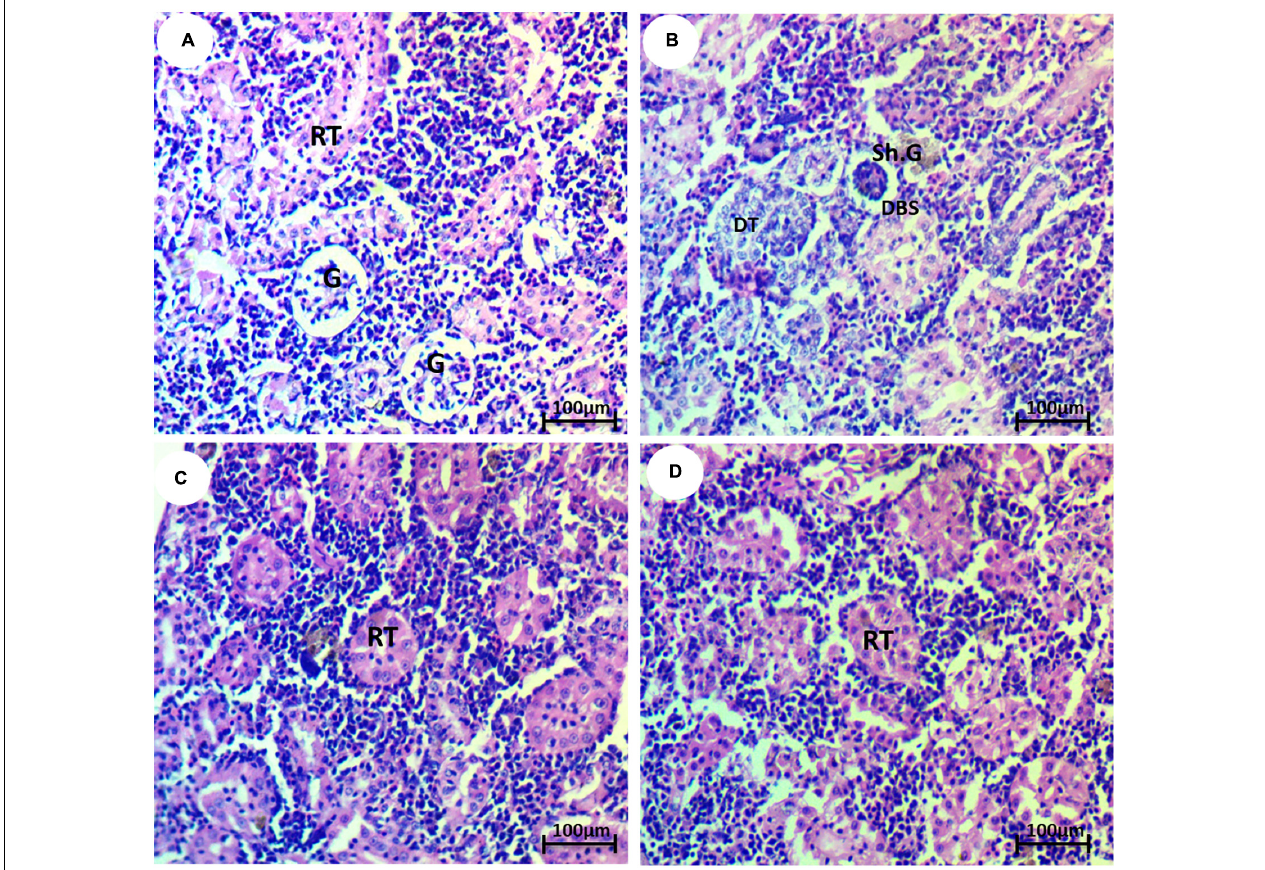
FIGURE 4 | Photomicrograph of kidney tissue of the African catfish ( Clarias gariepinus ) showing (A) normal architecture of glomerulus (H) and renal tubule (RT); (B) fish exposed to hydroxychloroquine showing degeneration of renal tubule (DT), shrinkage of the glomerulus (Sh.G), and dilation of Bowman’s space (DBS); (C) fish exposed to hydroxychloroquine + 10 mg/l Spirulina showing mild improvement of the renal tubule (RT); and (D) fish exposed to hydroxychloroquine + 20 mg/l Spirulina showing moderate improvement of the renal tubule (RT) (H&E stain, scale bar 50 µ